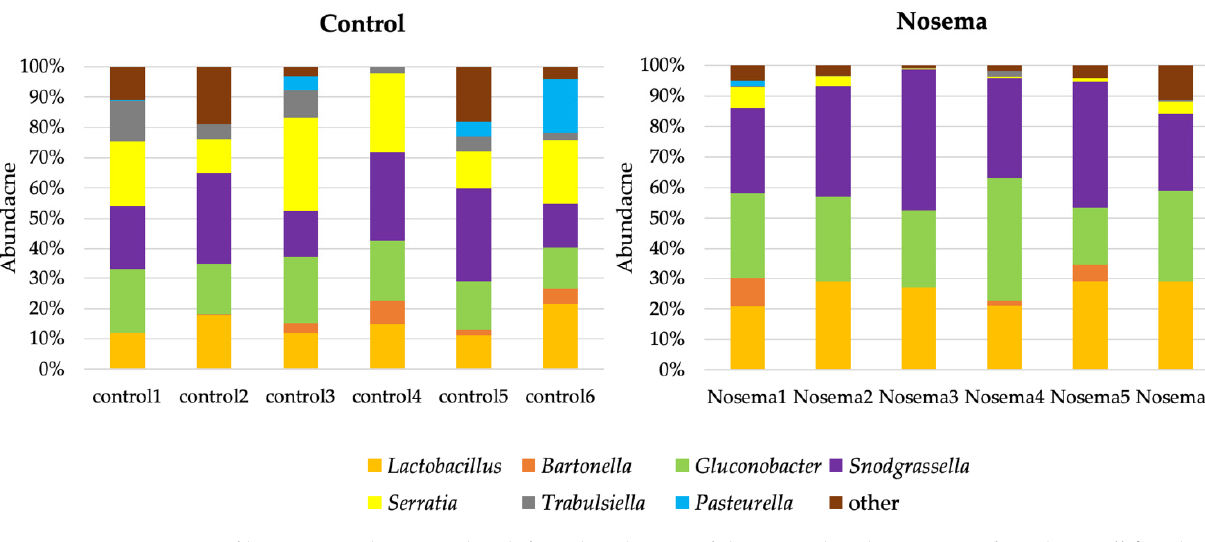
Figure 4. Proportion of bacteria, at the genus level, found in the gut of the control and Nosema-infected A. mellifera that showed significant difference, Lactobacillus ( t = 4.75, p < 0.001), Gluconobacter ( t = 3.2, p = 0.009), Snodgrassella ( t = 2.56, p = 0.028), Serratia ( t = 5.33, p < 0.001), and Trabulsiella ( t = 3.127, p = 0.01).